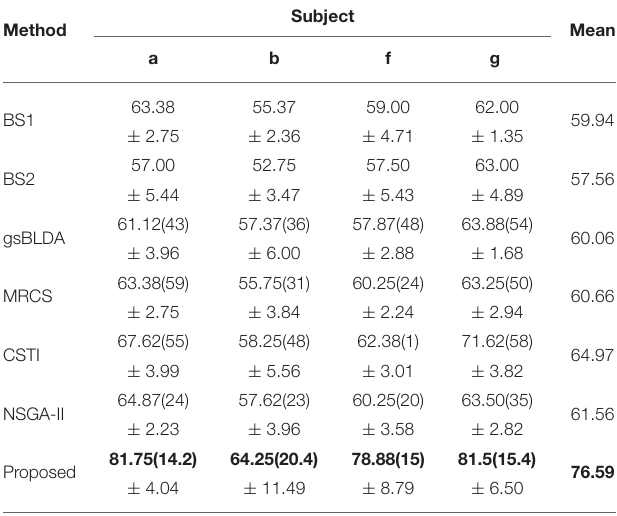
TABLE 10 | The mean classification accuracy and standard deviation (%) of 5 cross-validation (20% samples for training) with the number of corresponding channels (listed in the bracket) of COL and baselines on 4 subjects of